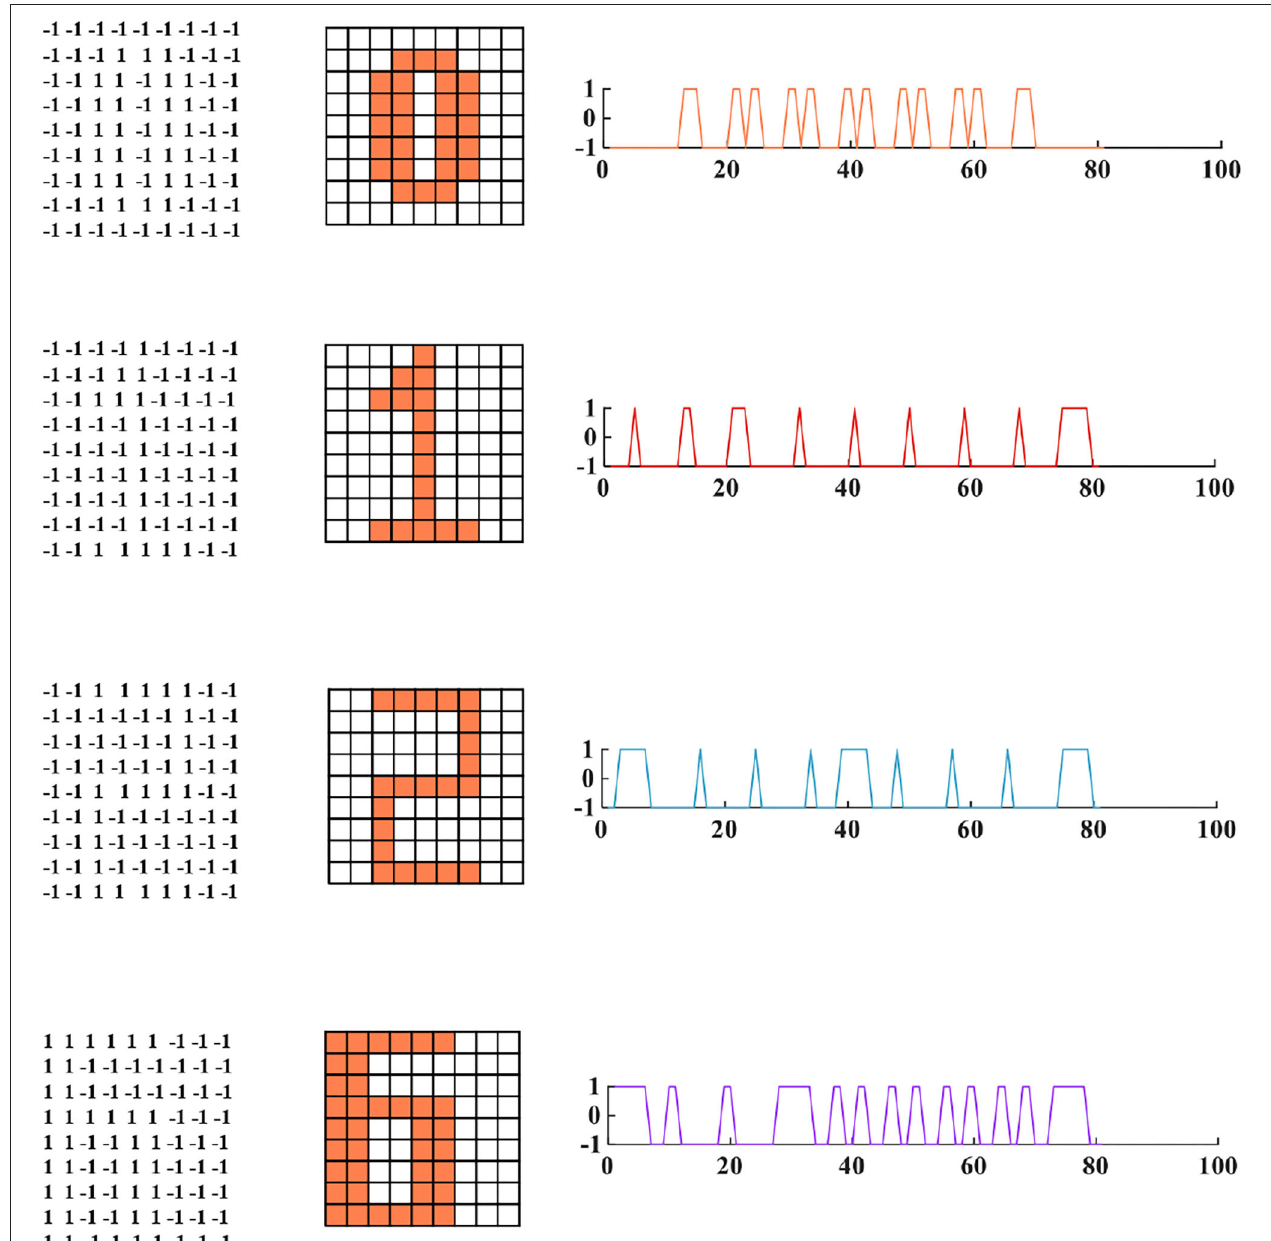
FIGURE 11 | The four fundamental memories for the MIZH oscillatory network ( left : the vector matrices of images are stored in the network; middle : the fundamental memories present in image formats of 9A–9 neurons (the coral grid represents + 1, the white grid represents − 1); right : the fundamental memories show as the square curve formats which correspond to the 81 state vectors in the left 9A–9